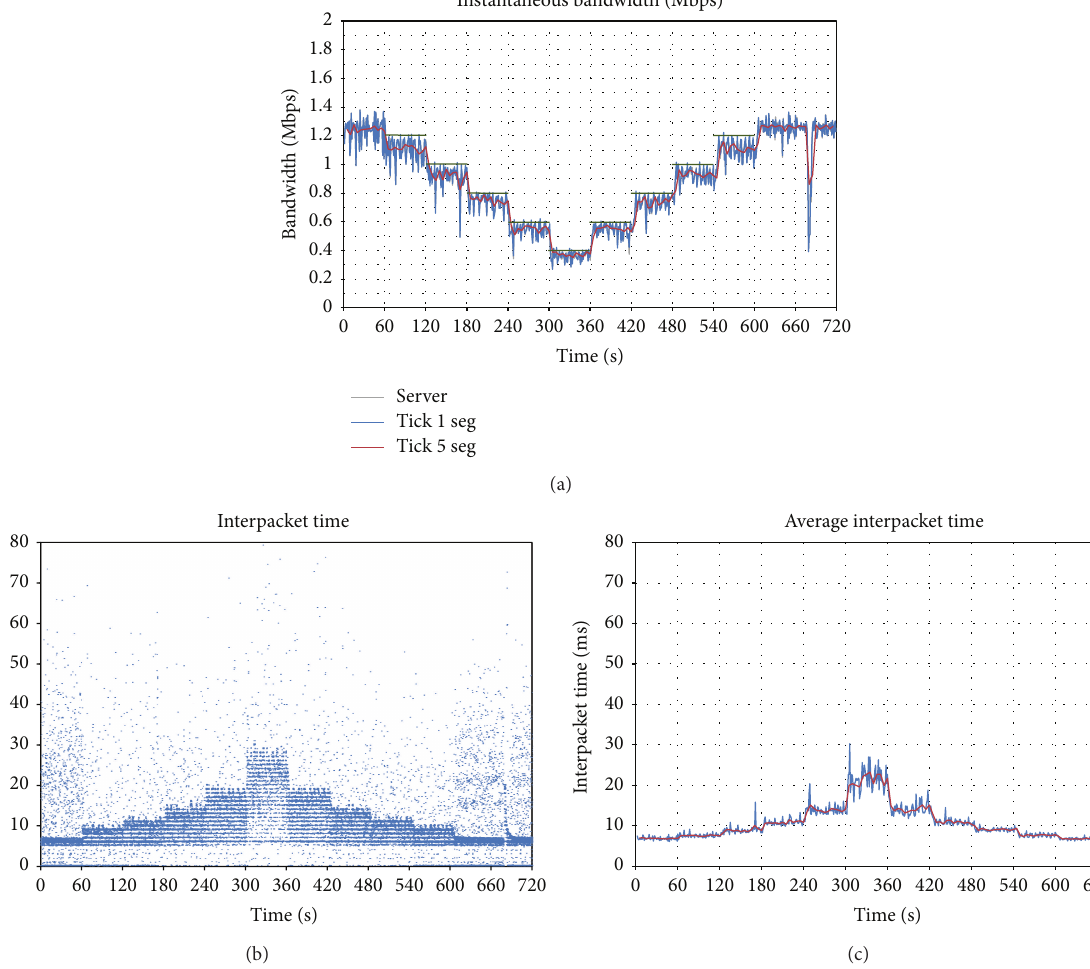
Figure 8: Effect of uplink bandwidth limitations on Vidyo : (a) evolution of sent throughput; (b) interpacket time; (c) average interpacket time.